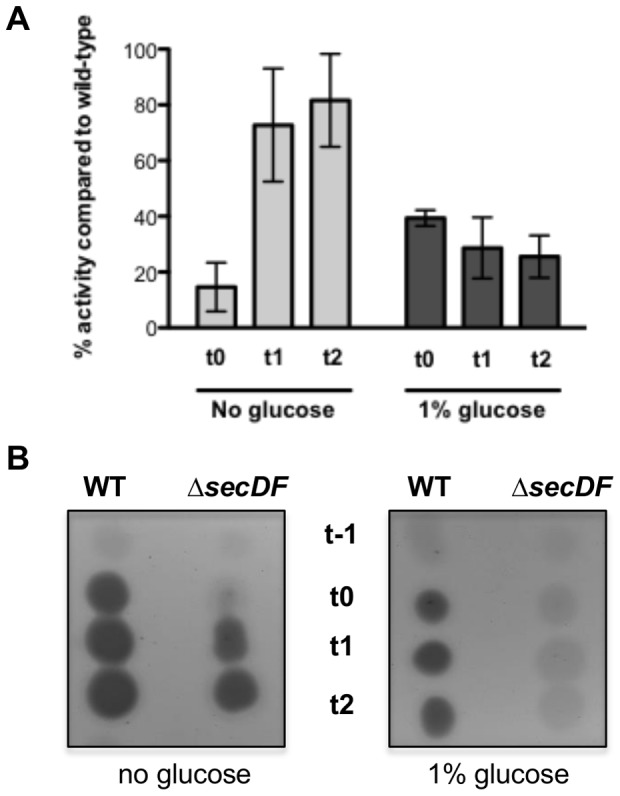
Reduced PC-PLC activity in the ΔsecDF mutant.A PC-PLC activity assay indicates reduced enzyme activity in the ΔsecDF mutant compared to the wild type strain. A) Filter-sterilized supernatant of cultures grown in LB (no glucose) or LBG (1% glucose) were assayed in a 2% egg-yolk solution. The results are the mean values of two independent experiments, and error bars represent standard deviations. B) Five µl of filter-sterilized supernatant of cultures grown in LB or LBG were spotted on 1% egg yolk agar plates. t0 marks the transition point of growth into stationary phase, and tn is the number of hours before (-) or after t0. The pictures represent one of two independent experiments.